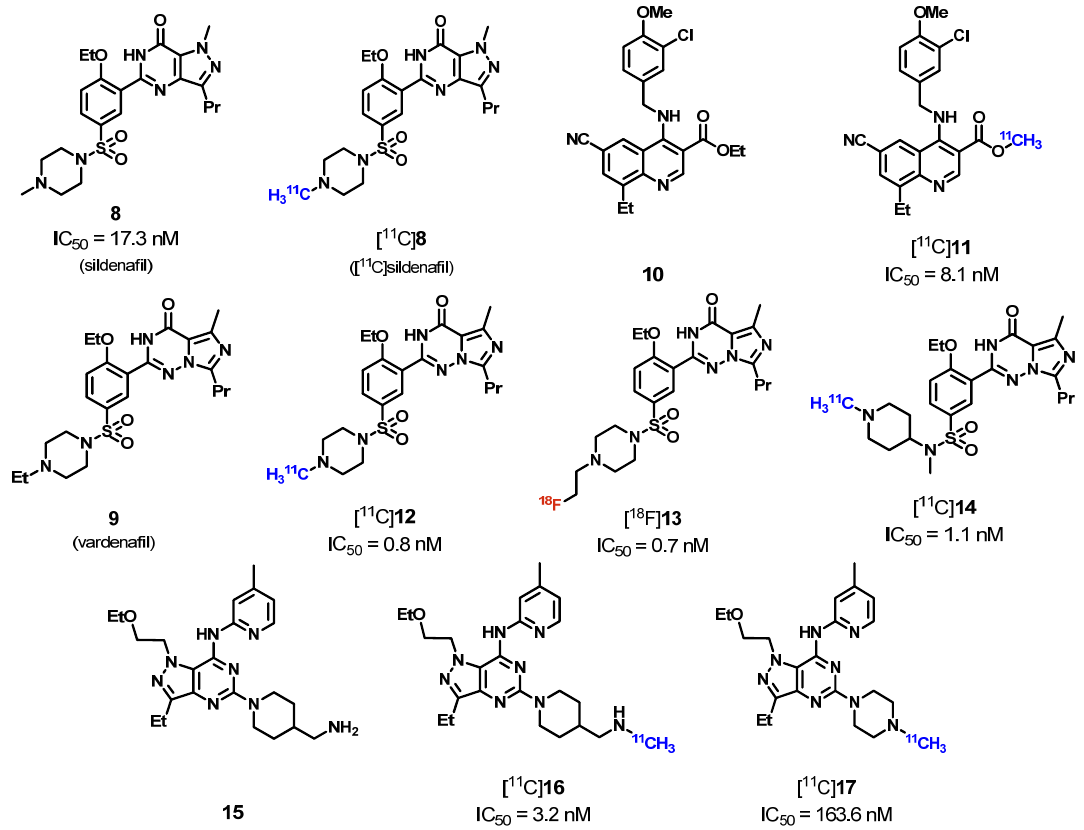
Figure 3. Figure 3. Molecular structures of PDE5A inhibitors and 11 C- or 18 F-labeled derivatives thereof for PET.